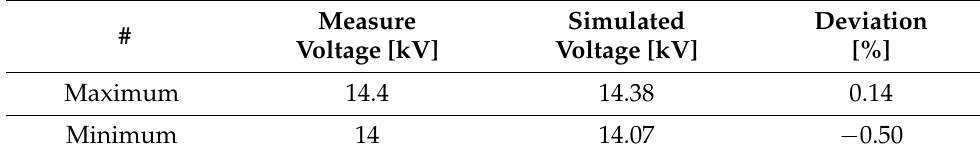
Table 6. Measured and simulated voltage values.